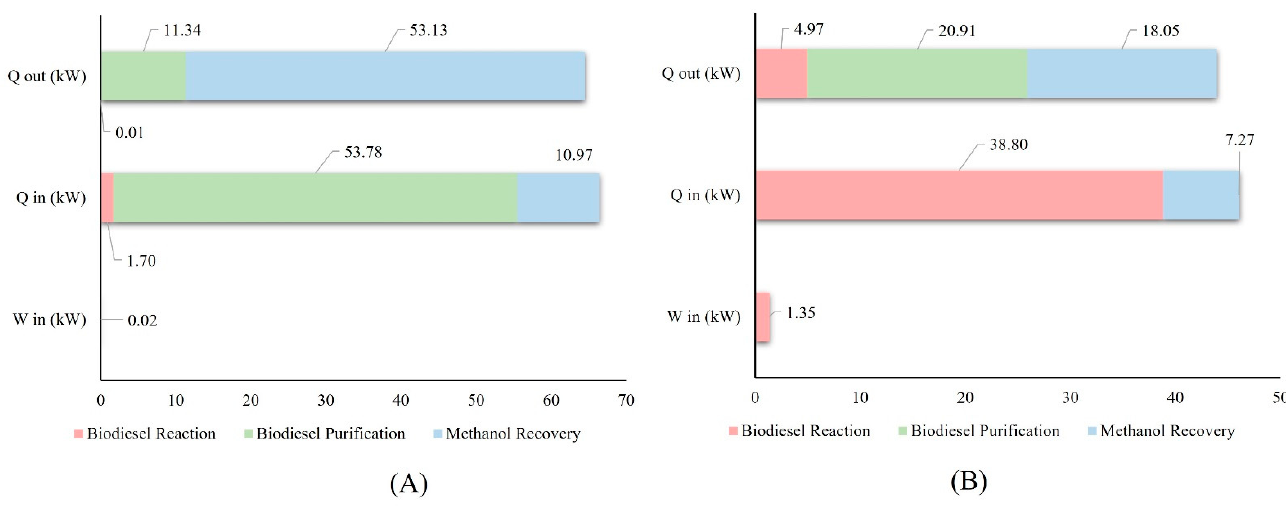
Table 5. Parameters of the array of parabolic trough collectors for each process. PARAMETER ALKALINE